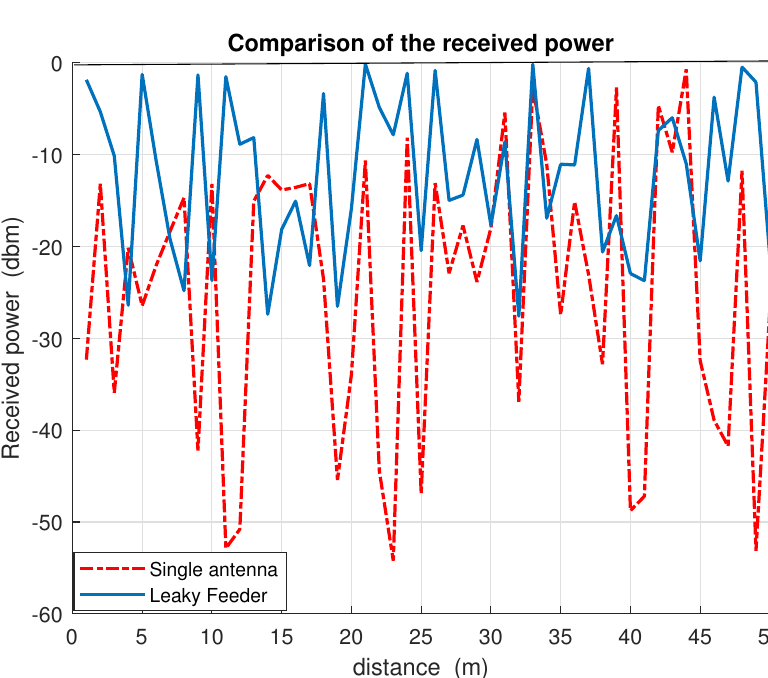
Figure 8. BER of LF for different values of M.